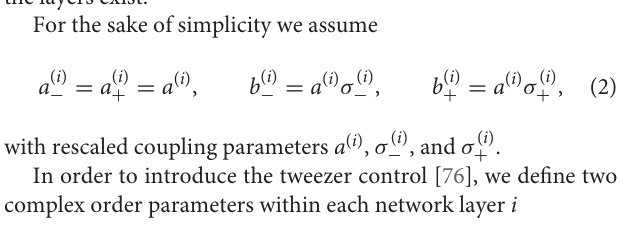
by dashed lines. This network structure can also be referred to as a multiplex , since only one-to-one inter-layer connections between the layers